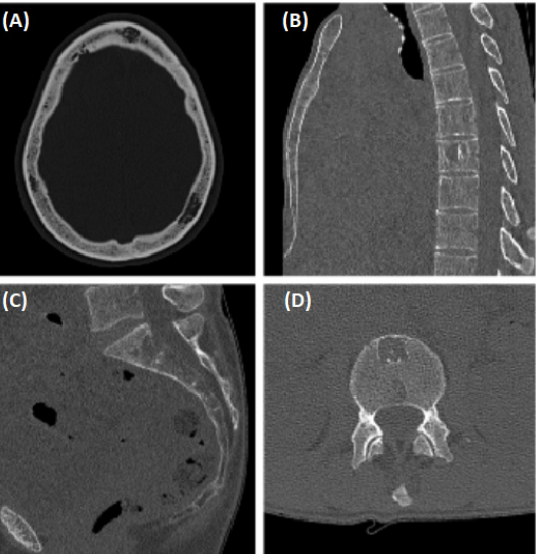
Figure 1. CT scans show areas of osteolysis: ( A )–in the frontal and parietal bones of cranium; ( B )–in thoracic vertebral body, Th8; ( C )–in sacral vertebra body, S1; ( D )–in lumbar vertebra body, L3.